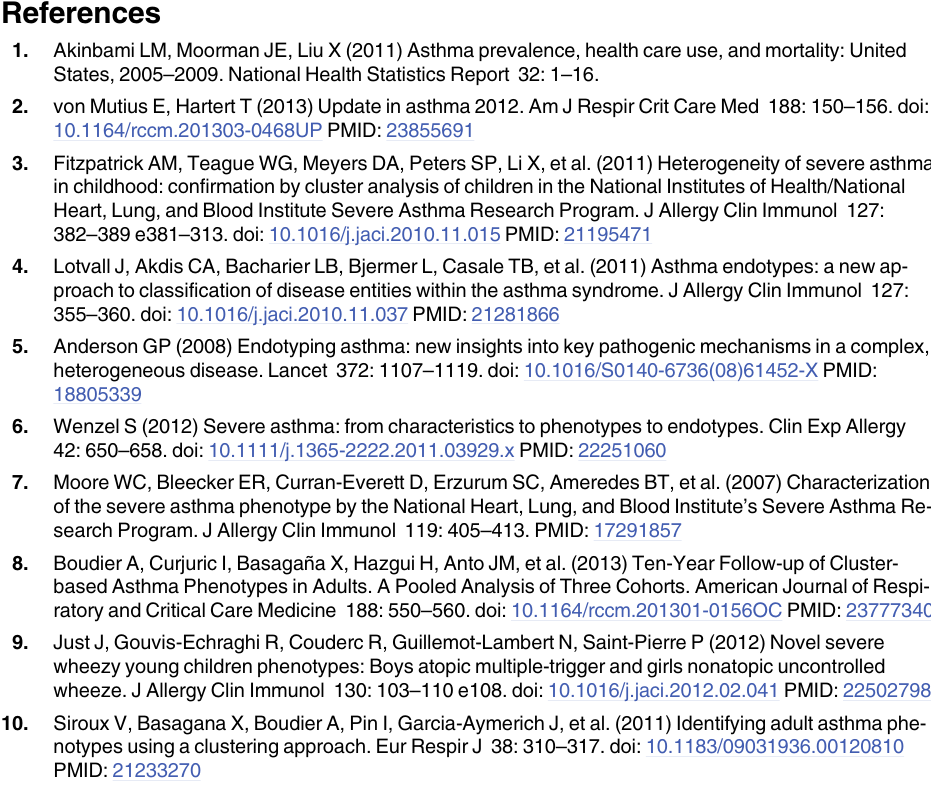
S6 Table. Biomarker listing with rows and groups as in Fig. 1A